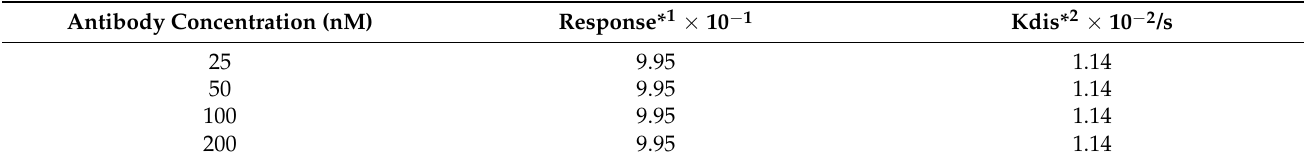
Each Value from Individual Concentrations is calculated by the Steady State Analysis Section of OCTET System Based on the Global Fitting Curves in Figure 5B. *1. Response Calculated from the Time Window Entered in the Steady State Analysis Section of OCTET System. *2. kdis (1/s) Value Corresponds the Rate of